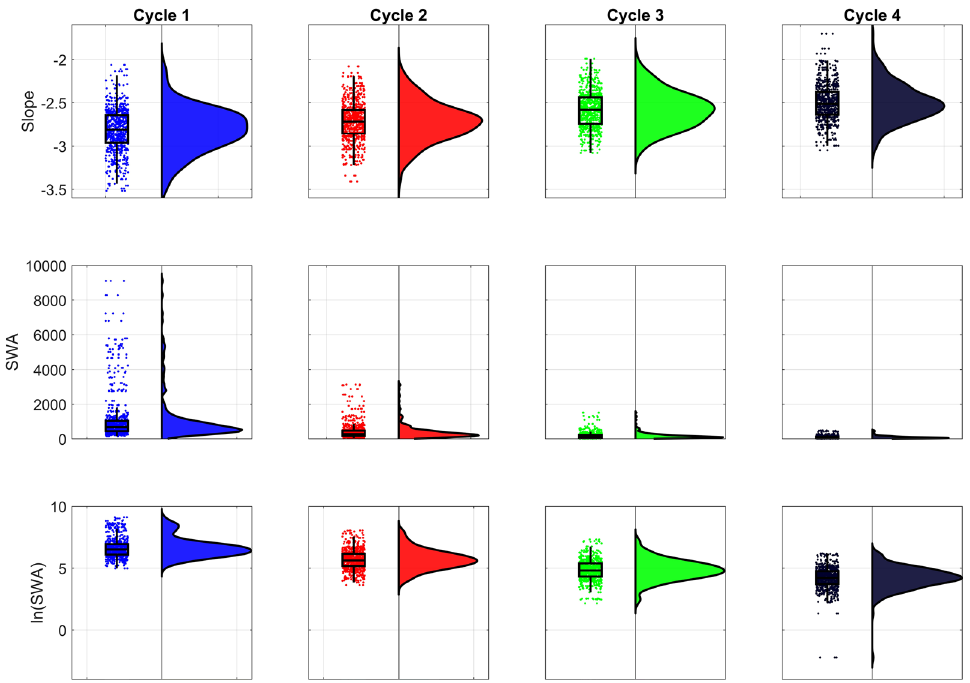
Figure 5. Raincloud plot of NREM sleep EEG spectral slopes, SWA, and lnSWA in the first four sleep cycles. Note the skewness and/or bimodality of the distributions, as well as the increased number of outliers of SWA and lnSWA compared to slope values.